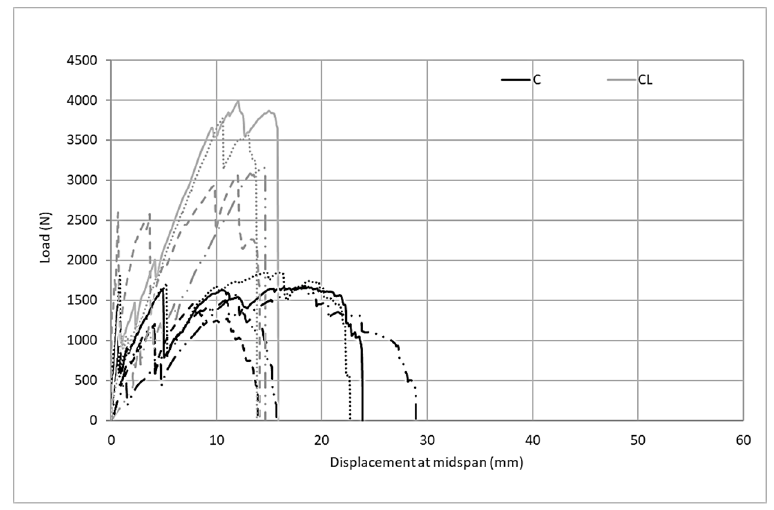
Figure 14. Load midspan displacement relations of M120 carbon composites at the flexure points.